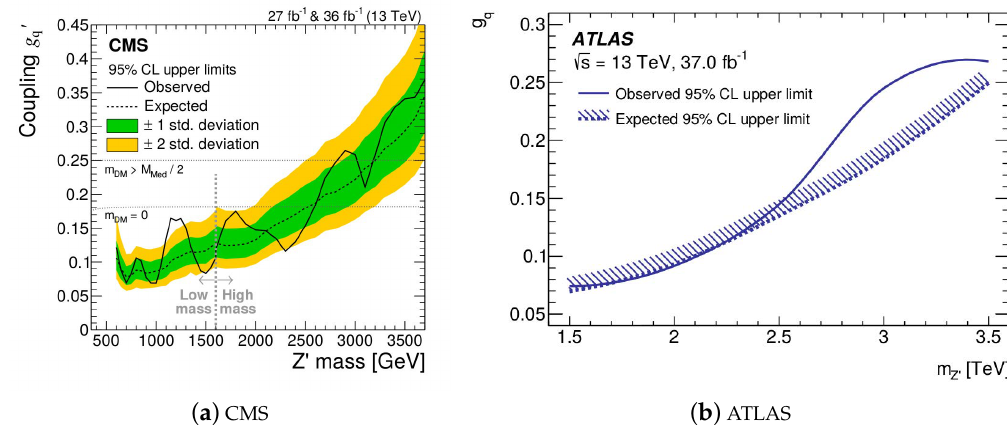
Figure 11. Results for the CMS [22] ( a ) and the ATLAS [23] ( b ) mediator searches. Limits on the mediator coupling to quarks (g q ) as a function of the mediator mass are set. The CMS plot shows also the results for low-mass mediator searches, for m med < 1.6